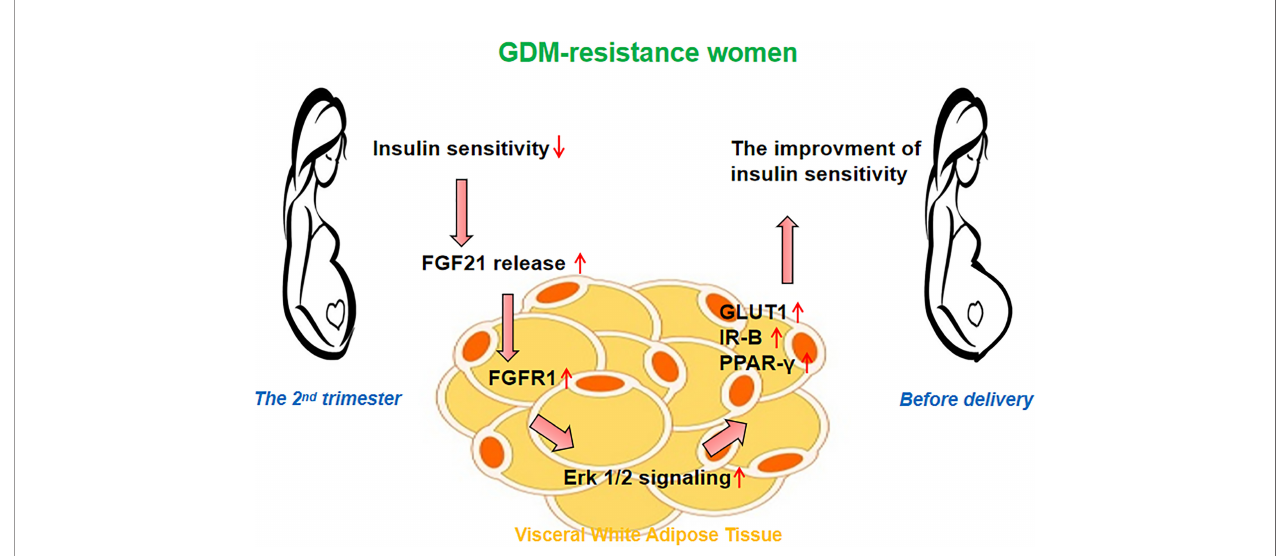
FIGURE 4 | Hypothesis on the role of FGF21 signaling in the visceral white adipose tissue (vWAT). The improved insulin sensitivity in women of the GDM-resistance group may be associated with the increased plasma FGF21 level and activated FGF21 signaling in